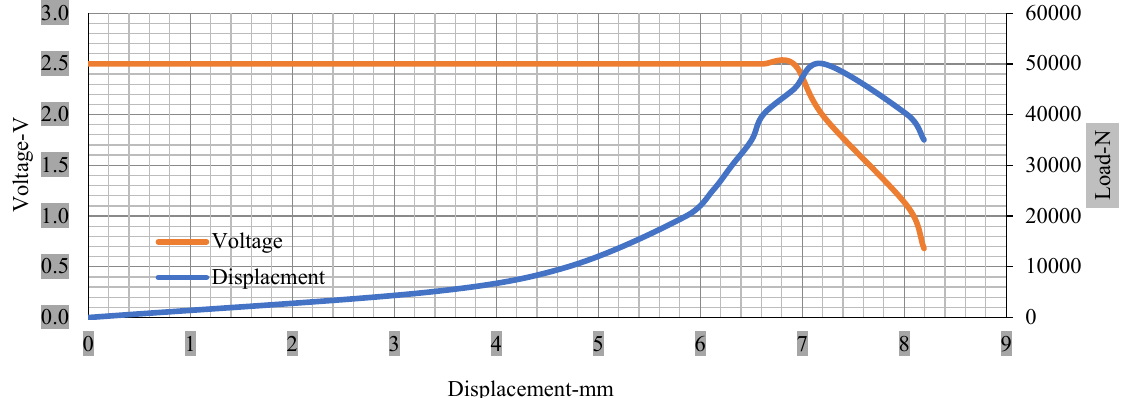
Figure 13. Load and voltage vs. displacement 44 mm punch less than 10% soc. Thus, the values for less than 10% soc drop in the voltage of small, medium punch,